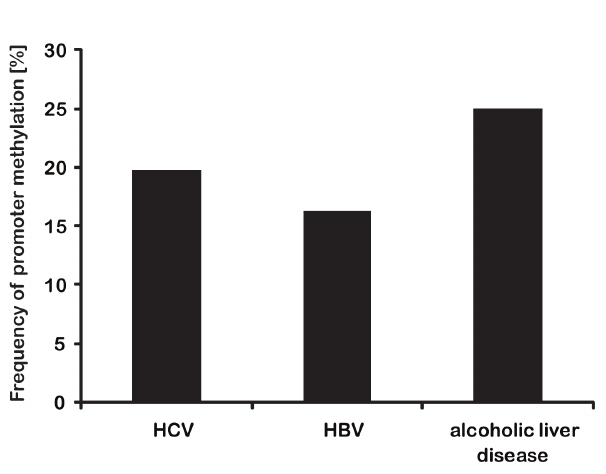
doi:10.1371/journal.pone.0084453.t003